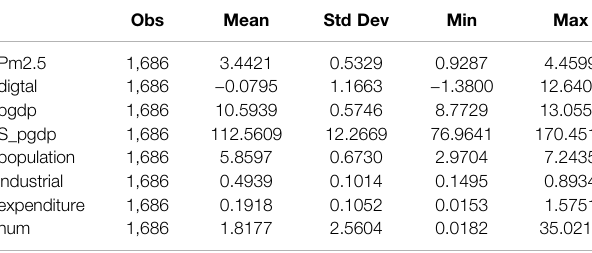
TABLE 1 | Statistical descriptions of the